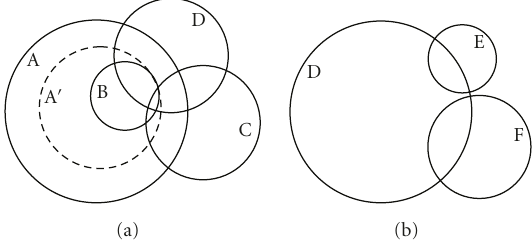
Figure 4: Situation of the arrangement of circular traces.